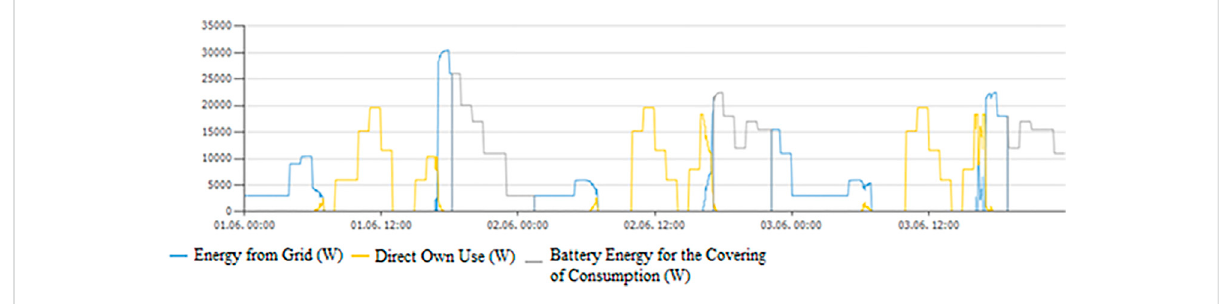
FIGURE 3 Energy consumption between 1 and 3 June: Direct own use, from grid, and